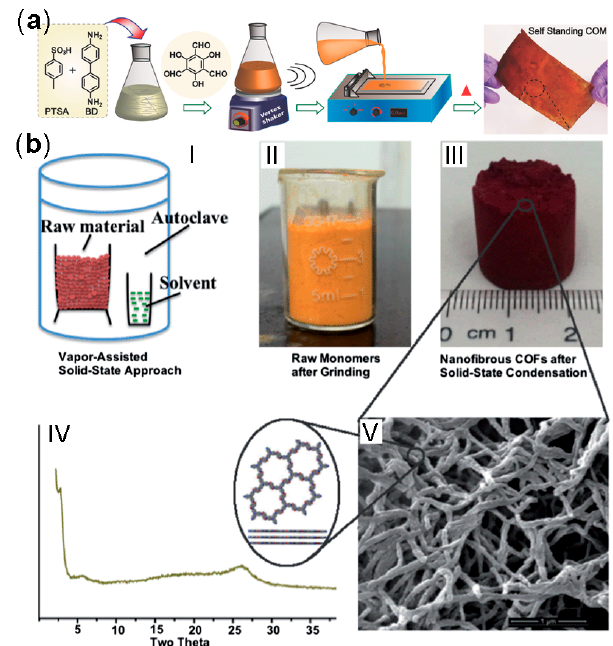
Figure 6. Schematic representations of ( a ) the fabrication of free-standing COF membranes, reproduced with permission from [198]. Copyright John Wiley and Sons, 2016; ( b ) vapor-assisted solid-state approach to synthesize nanofibrous COFs, reproduced with permission from [154]. Copyright Royal Society of Chemistry, 2014.